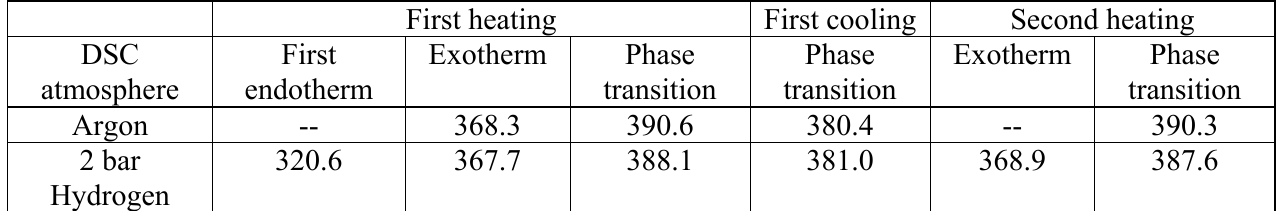
Table 1. Peak temperature (in K) measured in PDSC scans of unmilled LiBH and cooling rates: 20 K min –1 . Uncertainty in all measurements is ± 0.1